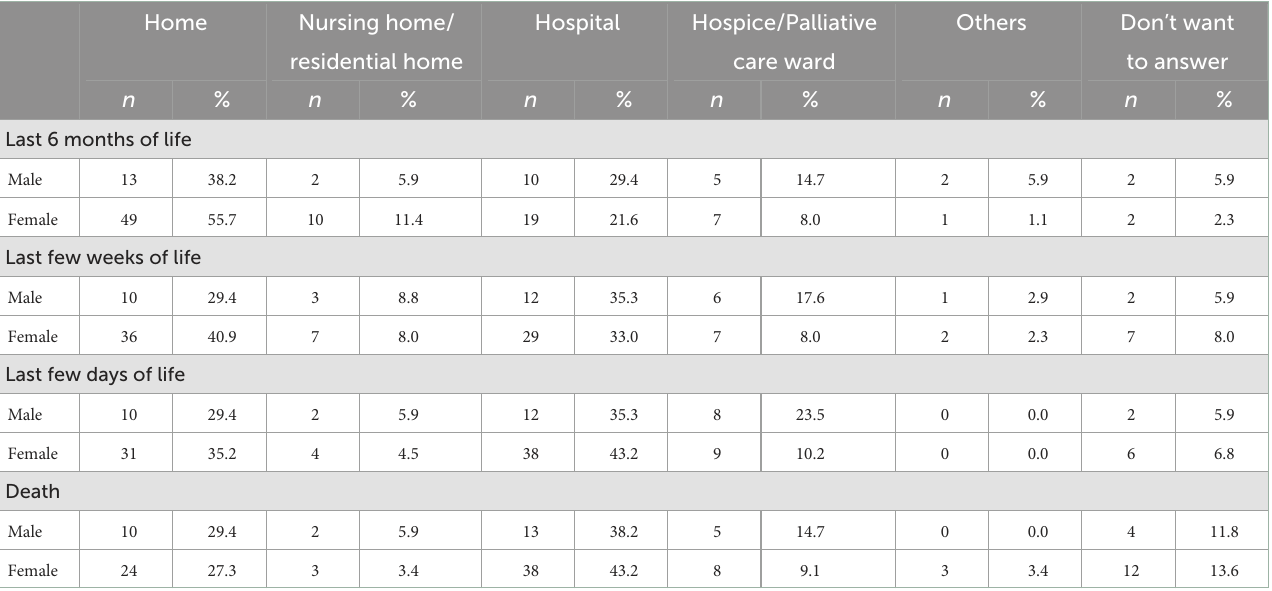
TABLE 4 Older respondents’ preferred place of end-of-life care and death by gender ( n =